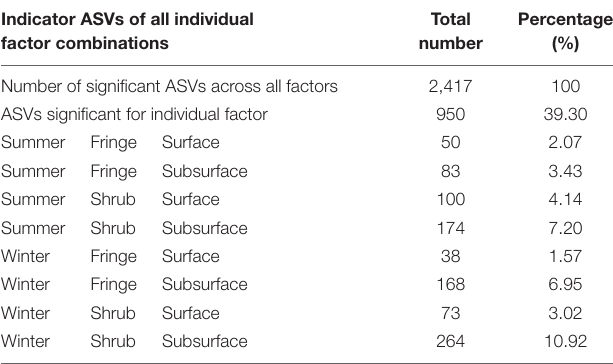
Indicator ASVs of all individual factor